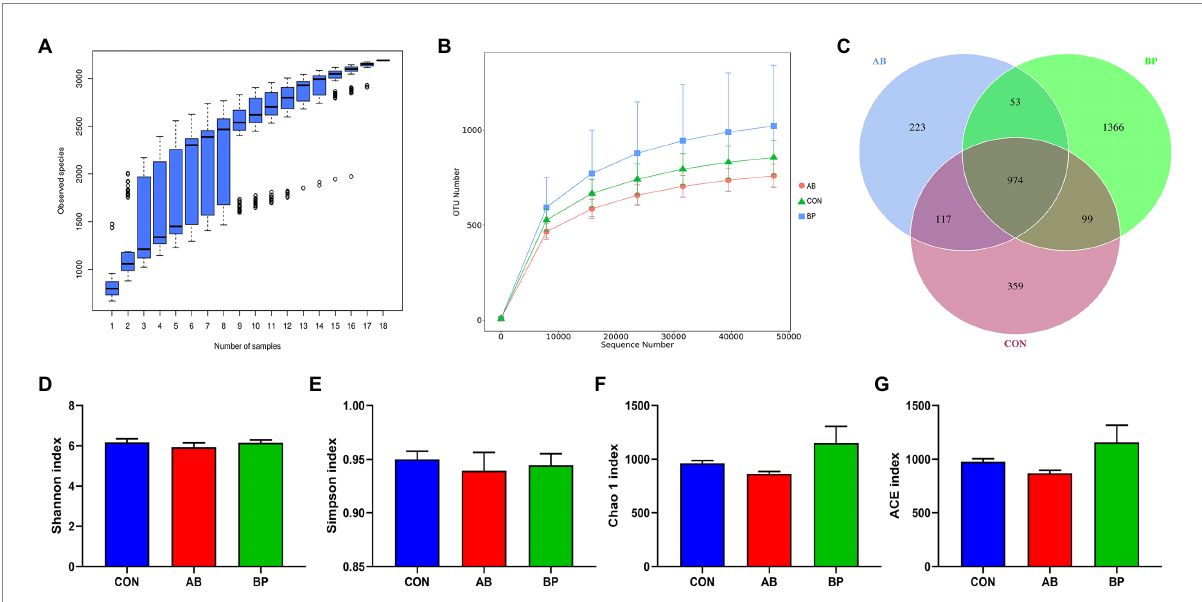
FIGURE 11 Differences in alpha diversity and richness among the three treatments. (A) The species accumulation curves; (B) The rarefaction curve of OTU; (C) Venn diagrams are displayed to describe the shared and unique sequences between processes; (D) Shannon index; (E) Simpson index; (F) Chao 1 index; and (G) ACE index. CON group, broiler chickens fed a basal diet; AB group, broiler chickens fed a basal diet supplemented with 50 mg/kg aureomycin; BP group, broiler chickens fed a basal diet supplemented with 40 mg/kg Bopu powder containing protopine and allocryptopine. n = 6. Differences between groups were considered significant at p <